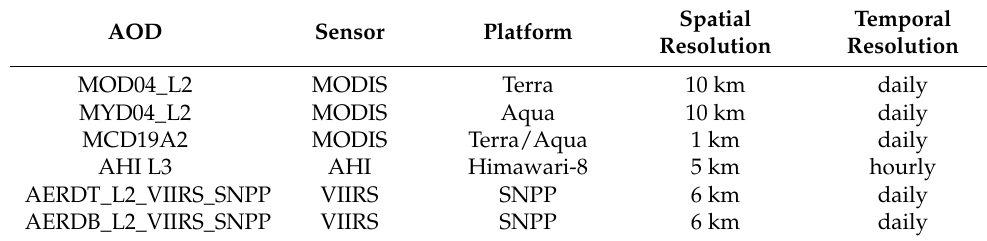
Table 1. Summary of the satellite AOD products used in this